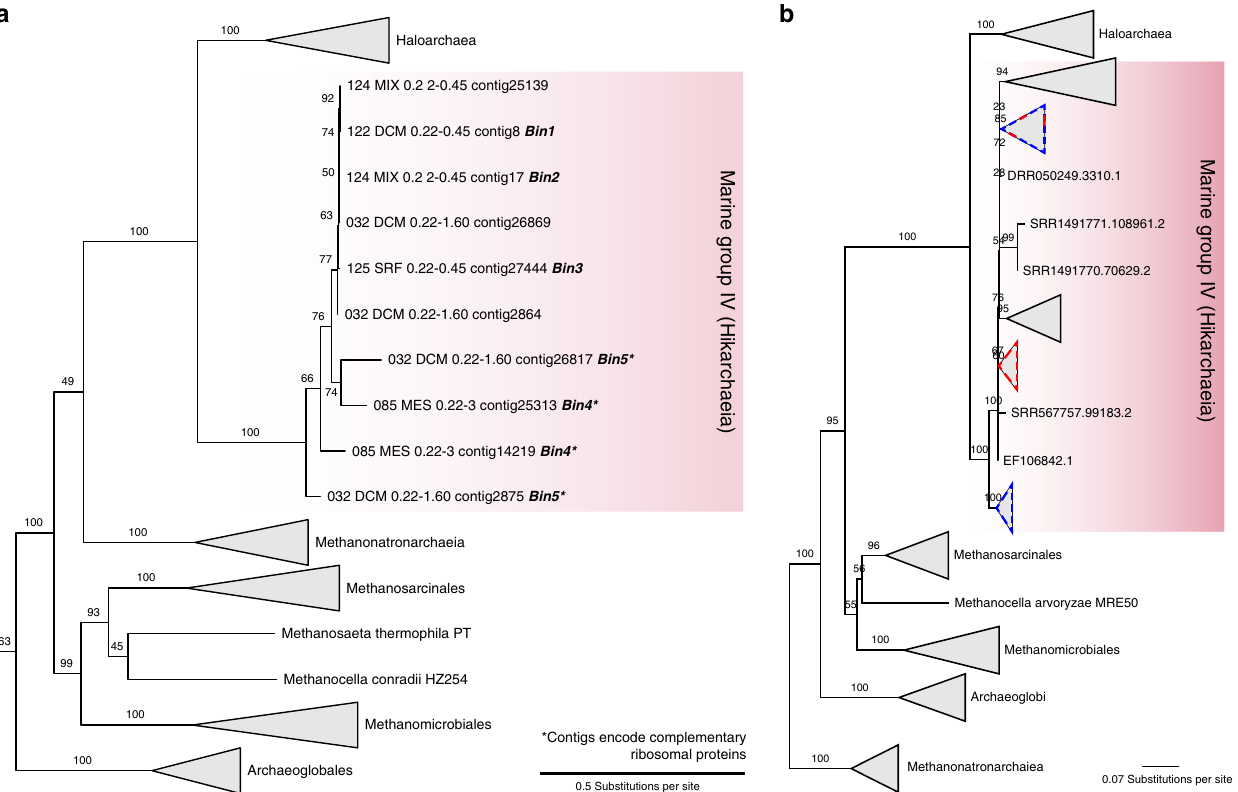
Fig. 1 Metagenomic exploration of Hikarchaeia. a Phylogenetic diversity of Hikarchaeia compared to a reference set of Haloarchaea, Methanonatronarchaeia, and other Euryarchaeota based on an RP15 analysis (see “ Methods ” ). Subtree of an RP15 tree representative of all archaea (Supplementary Fig. 1). b Unrooted phylogenetic tree of environmental 16S rRNA sequences of Hikarchaeia (see Supplementary Fig. 4 for full uncollapsed tree). Red and blue dash lines highlight Hikarchaeia clades that include the Hikarchaeia MAGs and the fi rst reported Hikarchaeia 16S rRNA gene sequences 40 ,